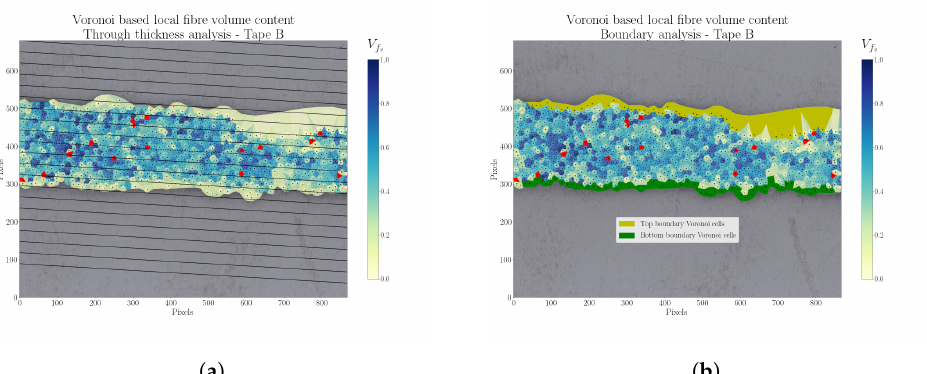
Figure 9. Example of results of the two developed analysis types: ( a ) through thickness analysis and ( b ) boundary analysis. Note that the red Voronoi cells represent a V f